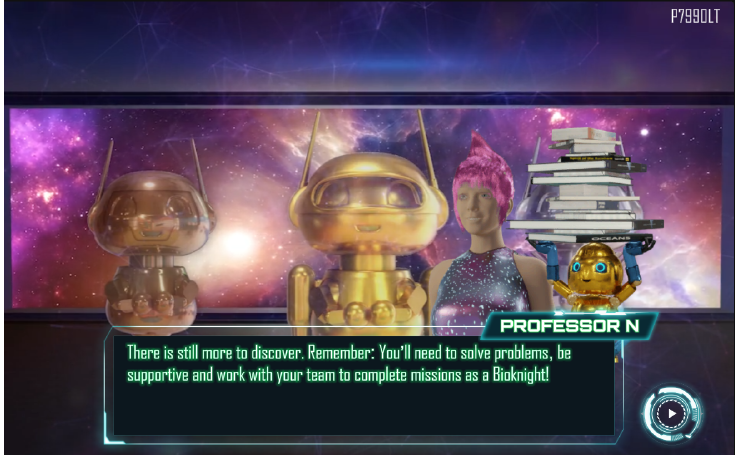
Figure A4. Example of final dialogue screen.